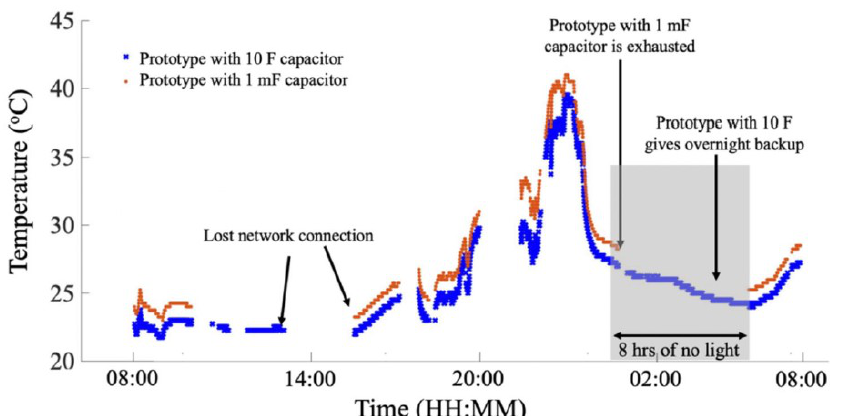
Figure 30. Results of the temperature sensor showing varying temperature and performance recorded for one full day